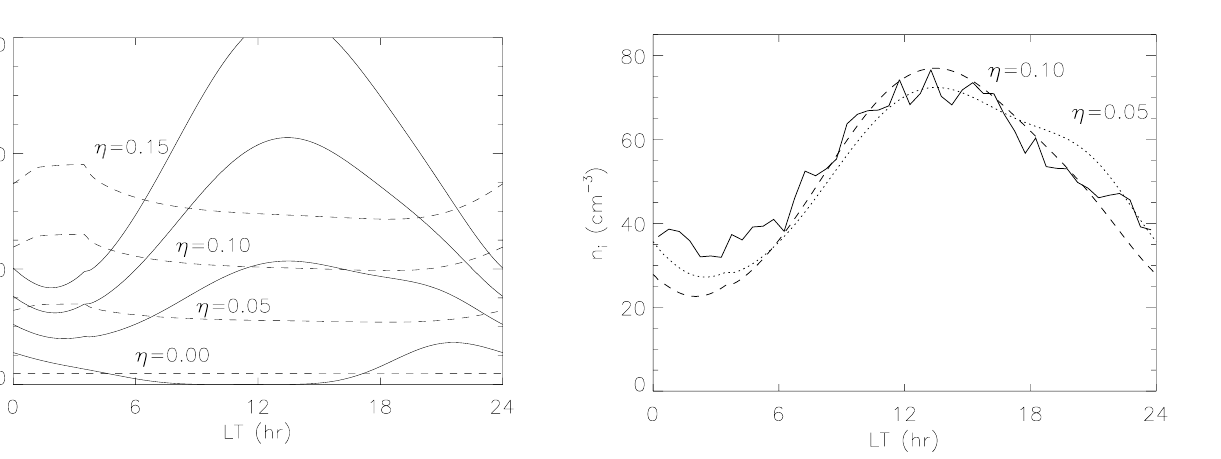
Fig. 5. MSKPM predictions with a uniform exobase and the parametrized FLIP exobase that varies with local time. The FLIP exobase is given by Eqs. 3–5, and the uniform exobase is obtained by using only the constant terms in the FLIP exobase.